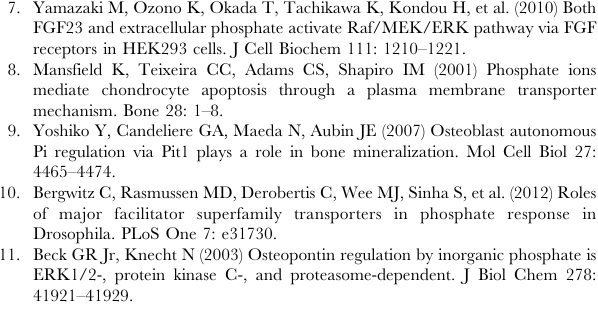
Shown is one representative experiment with cumulative fly counts, means of three vials per condition. Figure S3 Effect of phosphate, sevelamer and PFA on adult life span. A: Median life span of Canton S (CS) and Oregon R (OR) wild type males on standard medium or SM with 30 mM sodium phosphate or 1% sevelamer (CS: C, n =155; P30, n =62; Sev1, n= 58, OR: C, n = 117; P30, n= 52; Sev1, n =59). B: Median life span of y w males on standard medium, supplemented with 15, 30 and 60 mM sodium phosphate (C, n =550; P15, n = 282; P30, n= 465; P60, n= 115). To correct for the influence of osmolarity, life spans for P15, P30, and P60 are displayed as % of life spans for 15, 30, and 60 mM sodium sulfate, respectively. Figure S4 Dye uptake and excretion. A: Uptake of food dyes within 60 min. B: Dye excretion over 60 min. after flies were loaded with food dyes over night. C: Ratio of amount of dyes present in excretions (theoretical ratio 5.2 from fresh food is indicated by blue line). Figure S5 Adult hemolymph Pi, Phosphate excretion and whole fly Pi. Young adult w 1118 , Canton S or Oregon R females were cultured on standard medium alone or SM supplemented with 30 mM sodium phosphate (P30), or 1% sevelamer. Following culture for 5 days at 25 u C, phosphate excretion was determined (A )(n= 3, 20 flies each), and hemolymph phosphate (B) (n =3) and whole fly phosphate (C) (n= 10 individual flies) were measured. Figure S6 Genome-wide RNAi screen (Controls). 20,000 S2R + cells/384 well were treated with 0.375 ug dsRNA targeting Lac-Z, Ras85D, Dsor1/MEK, Rho1 and thread (A, primary screen) or LacZ, drk/GRB2, and Tao-1 (B, secondary screen)/well as described in materials and methods. After four days 10 mM phosphate (P10) (A, B), 50 ug/ml human insulin (C) or 30 uM of the MEK-inhibitor UO126 (UO126) were added for 10 min., followed by fixation and antibody staining for dpERK and cellular staining with Dead Red or DAPI and detection of total fluorescence with the appropriate filter sets. Ratios of dpERK signal over cell Dead Red or nuclear DAPI stain were expressed after subtraction of well background and wandering-median correction across each 384-well plate as z- scores. Figure S7 P-induced ERK activation in murine and Drosophila cells is blocked by RNAi-knockdown of